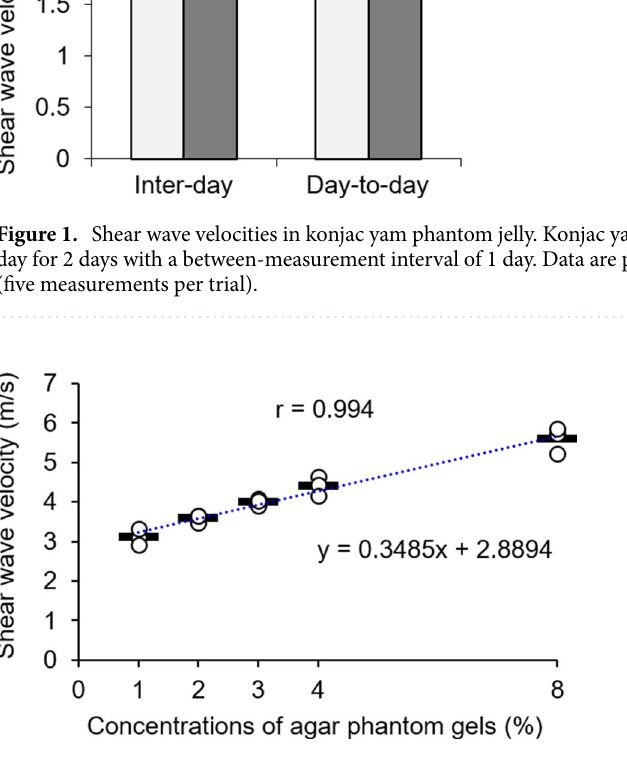
Figure 2. Shear wave velocities in agar phantom gels. The shear wave velocities in agar phantom gels (1%, 2%, 3%, 4%, and 8%) were measured three times. Horizontal bars indicate mean values.